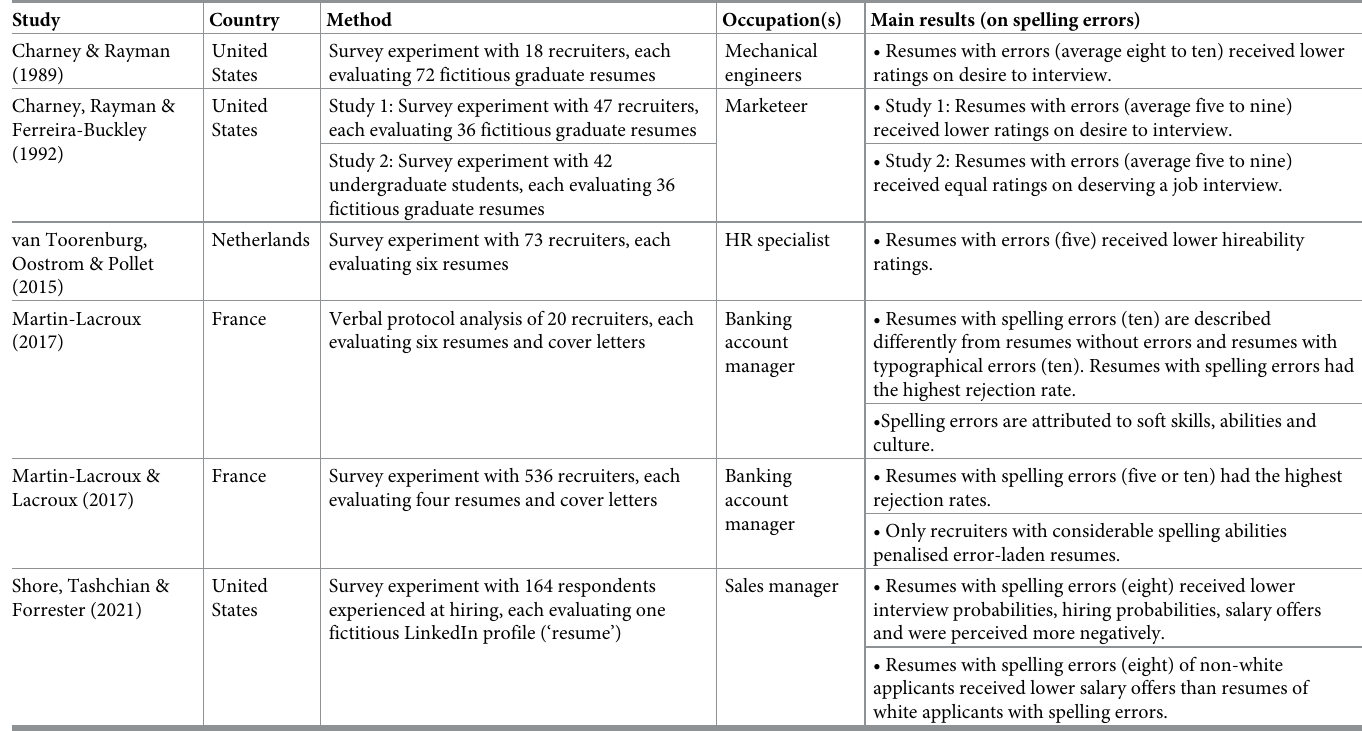
Table 1. Spelling errors during resume screening: Literature